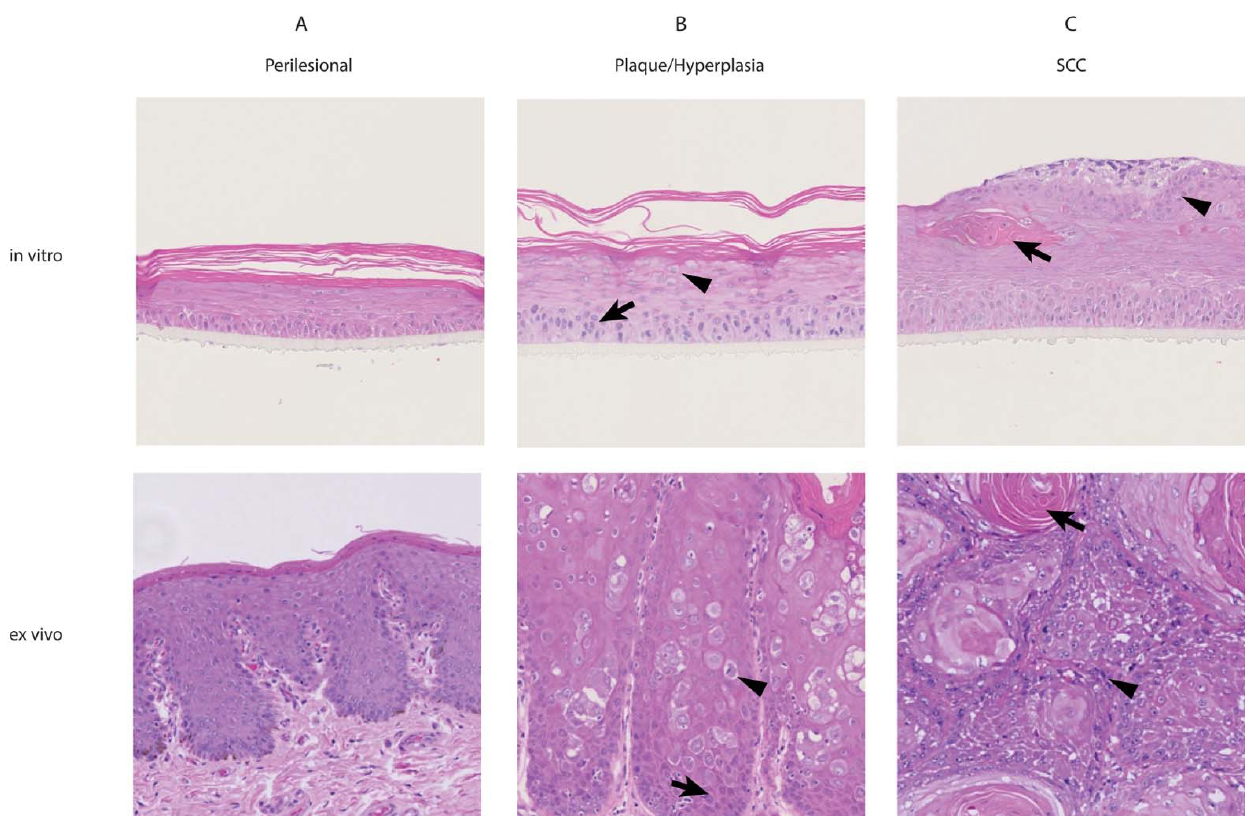
Figure 1. H&E staining of raft cultures and corresponding tissue sections. Representative areas of perilesional ( A ), plaque/hyperplasia ( B ) and squamous cell carcinoma (SCC) ( C ) raft cultures and tissue sections. Raft cultures derived from the three different ex vivo tissue sources correspond to their respective tissue of origin in terms of proliferation and differentiation. ( A ) Raft cultures derived from perilesional skin accurately reflect the keratinocyte differentiation process of normal skin. ( B ) Raft cultures derived from penile plaques are structurally organized but show early hyperplasia and crowding of basal cells (arrow) and hypertrophy of keratinocytes with occasional perinuclear halos (arrowhead). This is similar to the foci of hyperplasia (arrow) and koilocyte-like cells (arrowhead) present in the corresponding tissue section. ( C ) Raft cultures derived from penile SCCs exhibit marked hyperplasia and dysplasia. Of note are clusters of anucleate eosinophilic cells, suggestive of early keratinization (arrow), and clusters of basaloid cells (arrowhead) within the stratum spinosum, which likely mimic the keratin pearls (arrow) and infiltrative islands of epithelial cells (arrowhead) that characterize SCCs. All photographs taken using 10× objective. H&E stain.